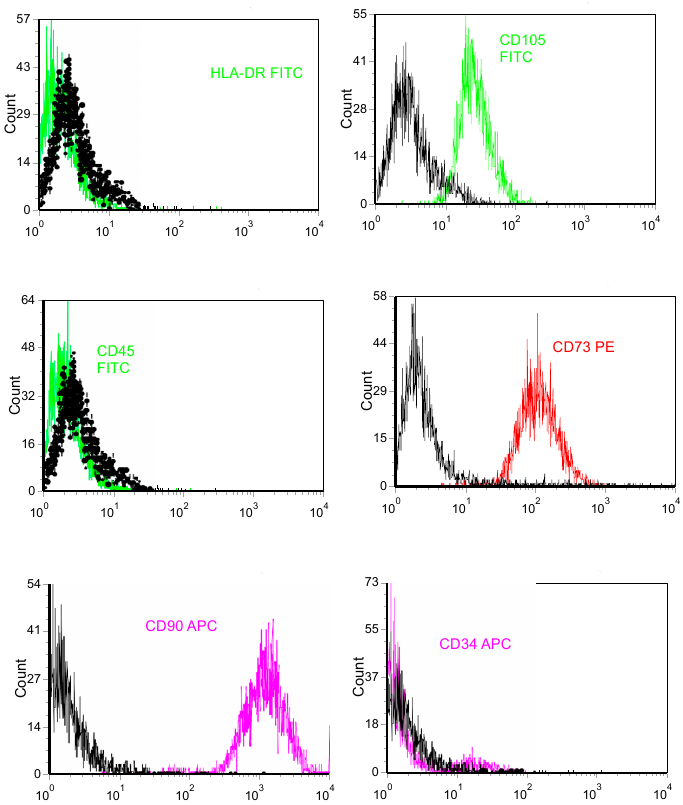
Figure 1. Immunophenotypic characterization of h BMMSCs by flow cytometry for the expression of mesenchymal (CD90, CD73, CD105/endoglin), hematopoietic (CD34, CD45) and HLA-DR markers (black line: unstained control; red, green and purple line: marker of interest). Results are means of triplicates (±SD) of three independent experiments.